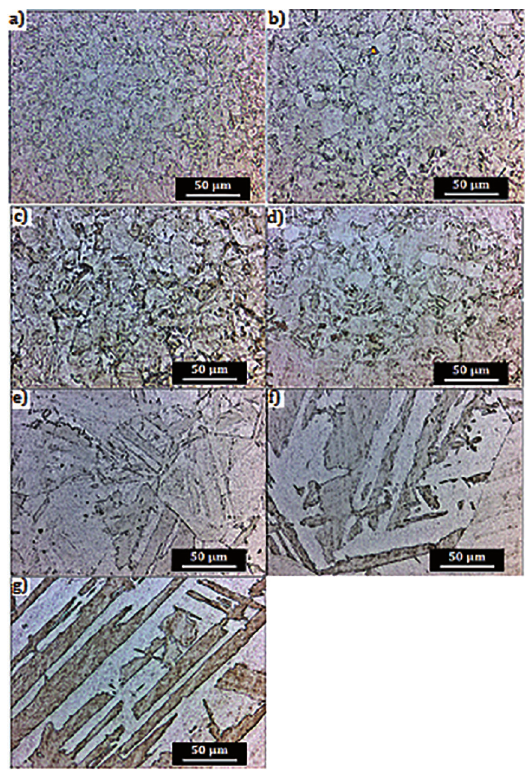
Figure 3: Microstructure of samples solution annealed for 1 hour at a) 860 °C, b) 900 °C, c) 950 °C, d) 1000 °C, e) 1050 °C f) 1100 °C g) 1150 °C. Magnification 500x.